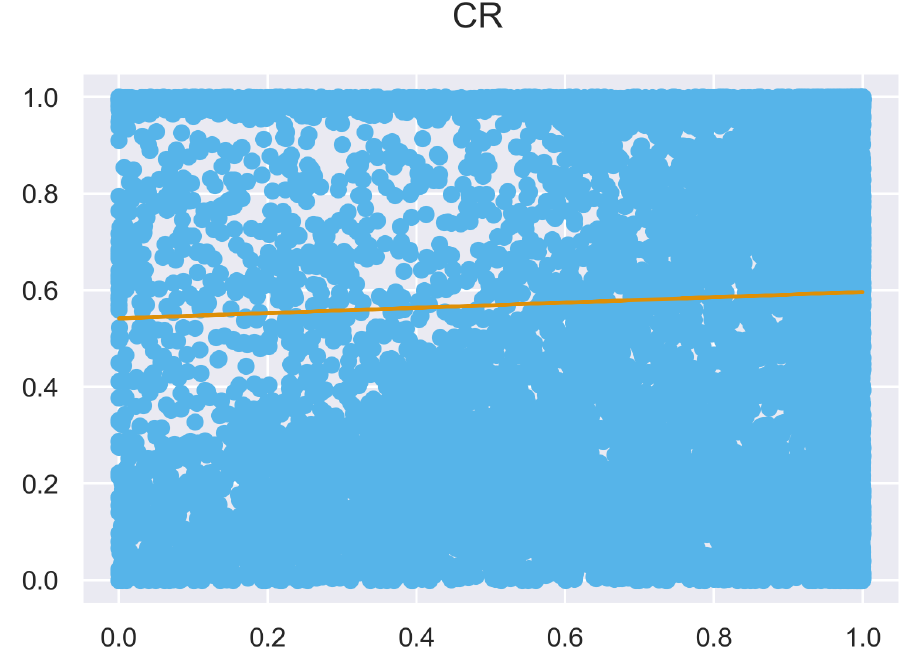
Figure A9. ULS and TLS CR regression at 0.5 m grid size.